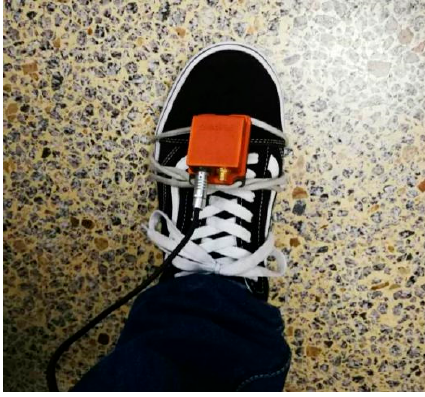
Figure 10. Inertial measurement unit (IMU) fixed to the experimenter’s foot.